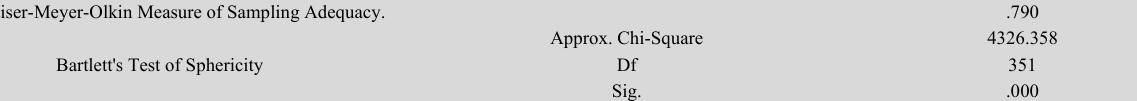
Correlate testing of observed variables in a representative measure Bartlett’s test has Sig = 0.00 <0.05, meaning that the representative factor and observed variables are linearly correlated (See